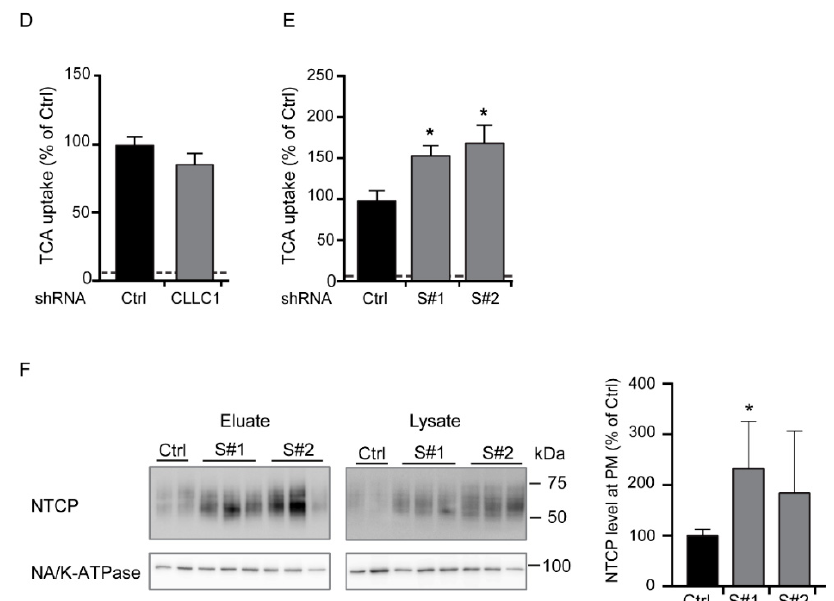
Figure4. E ff ectofCLCC1andstomatinknockdownandoverexpressiononNTCP.( A , B )NTCP-mediated TCA uptake in HepG2 cells expressing either an empty vector (EV) V5-stomatin (V5-STOM) ( C ) or V5-CLCC1. ( C ) Cell surface biotinylation assay showing NTCP expression at the plasma membrane (eluate) and in the total lysate fraction in HepG2 stably expressing HA-hNTCP and either an empty vector (EV) or V5-stomatin (V5-STOM). Quantification of the NTCP plasma membrane fraction is shown on the right. ( D , E ) NTCP-mediated TCA uptake in HepG2 cells expressing either a scramble shRNA (Ctrl), a shRNA targeting CLCC1 ( D ), or a shRNA targeting stomatin (E, S#1, S#2). ( F ) Cell surface biotinylation assay showing NTCP expression at the plasma membrane (eluate; left) and in the total lysate fraction (middle) in HepG2 cells stably expressing HA-hNTCP and either a control vector or a shRNA against stomatin (S#1, S#2). Quantification of NTCP at the plasma membrane is shown on the right. ( A , B , D , E ) Representative experiments from nine independent experiments, performed in quadruplicate. Data are shown as mean +/ − SD where TCA uptake or NTCP cell surface abundance of control transduced cells is set at 100%. *P < 0.05, compared to control cells (Mann–Whitney test). The dotted line represents the level of uptake in cells lacking NTCP. ( C , F ) Eluate: plasma membrane fraction, lysate: total proteins. P: cells without NTCP, NB: no sulfo-NHS-ss-biotin added. Western blots are representative of at least three independent